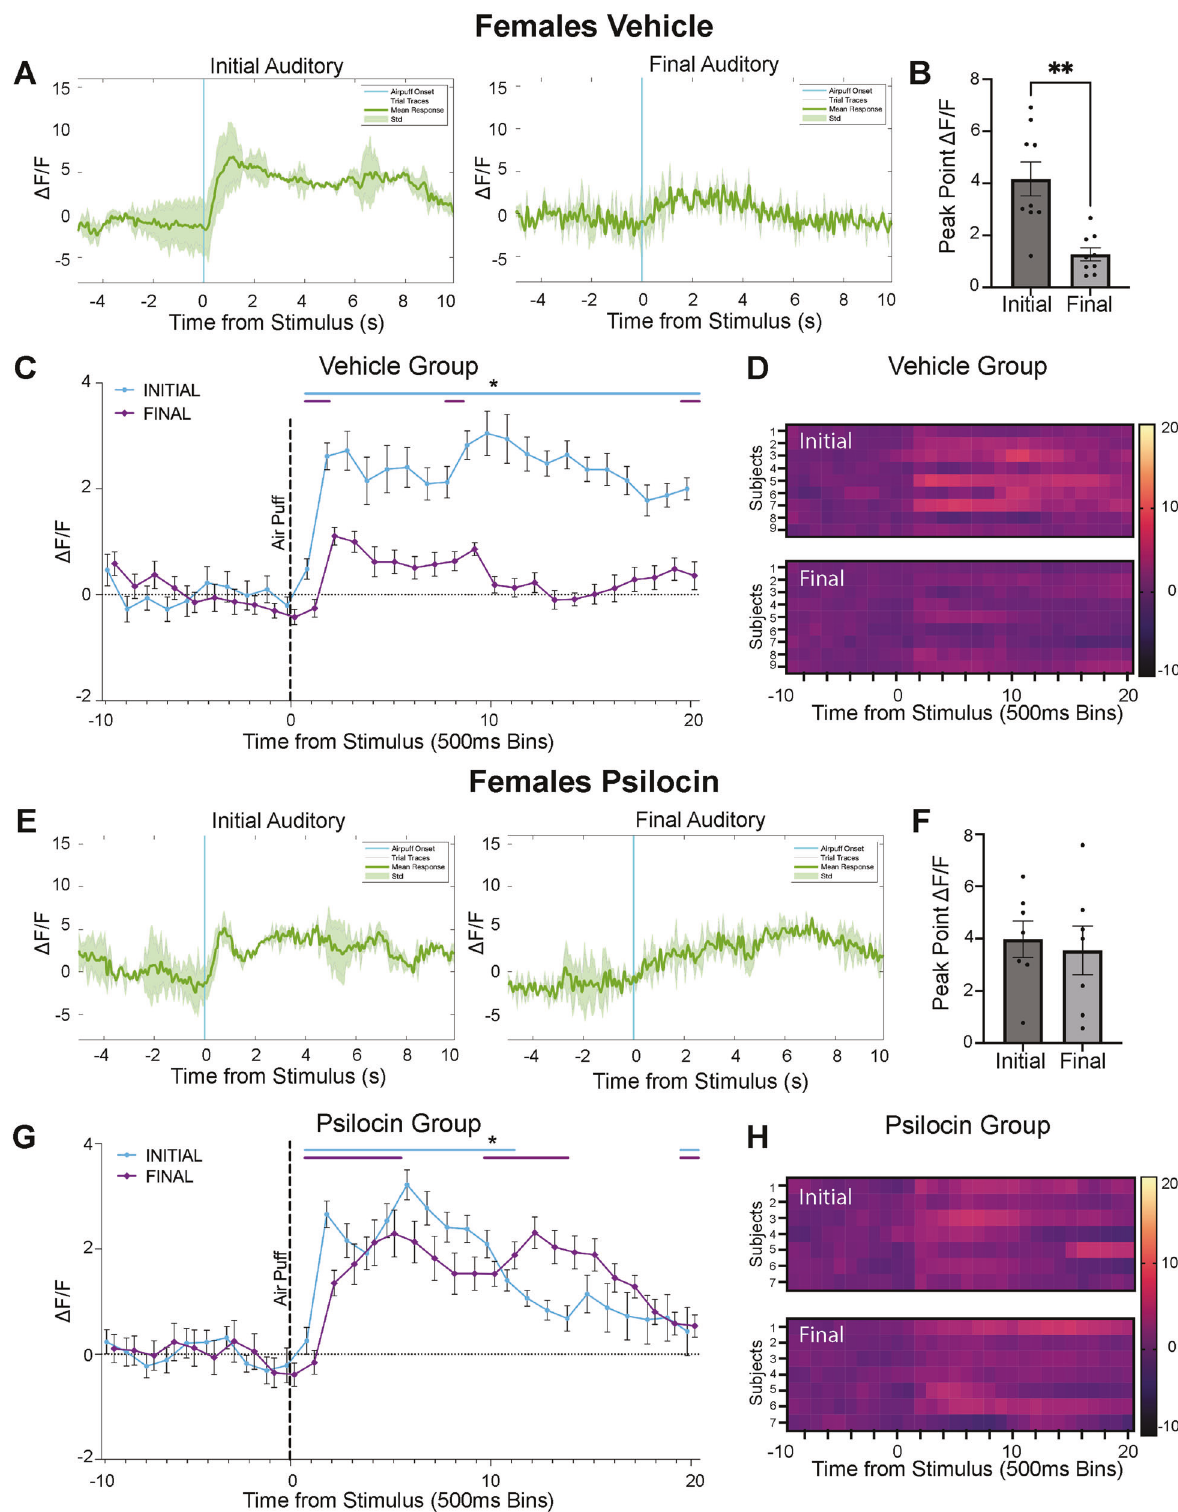
an increase in CeA c-Fos expression in both males and females following administration of psilocin, with region speci fi c increases found in the CeC subregion in females. CeA reactivity was assessed using fi ber photometry to measure in vivo